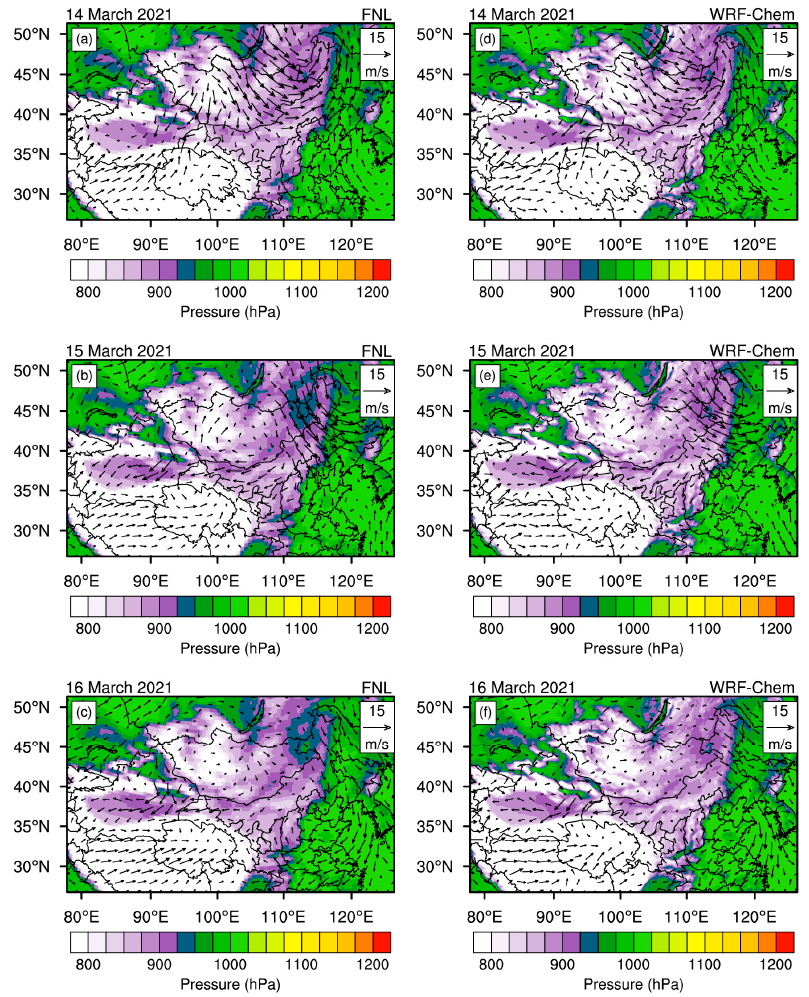
Figure 3. Daily mean 10 m wind fields (units: m/s) over the surface pressure (hPa) derived from Final Reanalysis Data (FNL) ( a – c ) and WRF-Chem ( d – f ) from 14 to 16 March 2021. The color contours show the daily mean surface pressure. Vectors represent the daily mean wind fields at 10 m. The spatial distributions of the observed and simulated PM 10 and PM 2.5 surface mass concentrations are shown in Figures 4 and 5, respectively. Due to the limitations of the observation datum, the simulated dust mass concentrations are evaluated only by the observations in